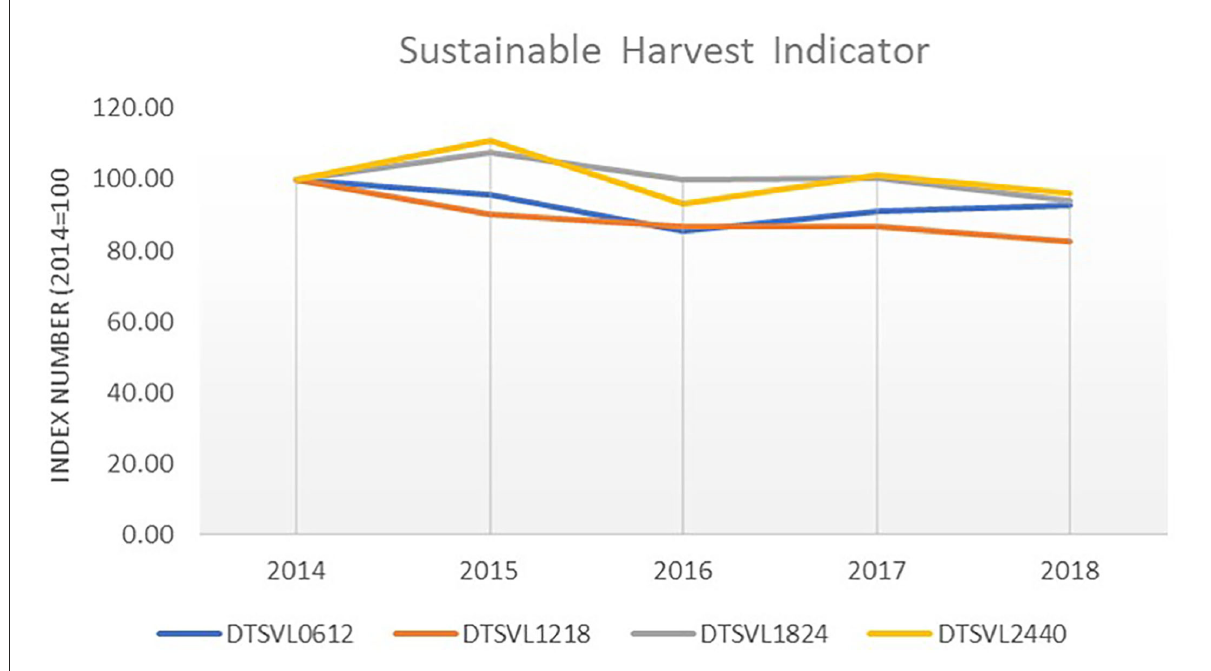
FIGURE8 SHI trend for the Italian demersal trawl fleet for the 2014–2018 period. Elaboration on data from STECF (20-10).